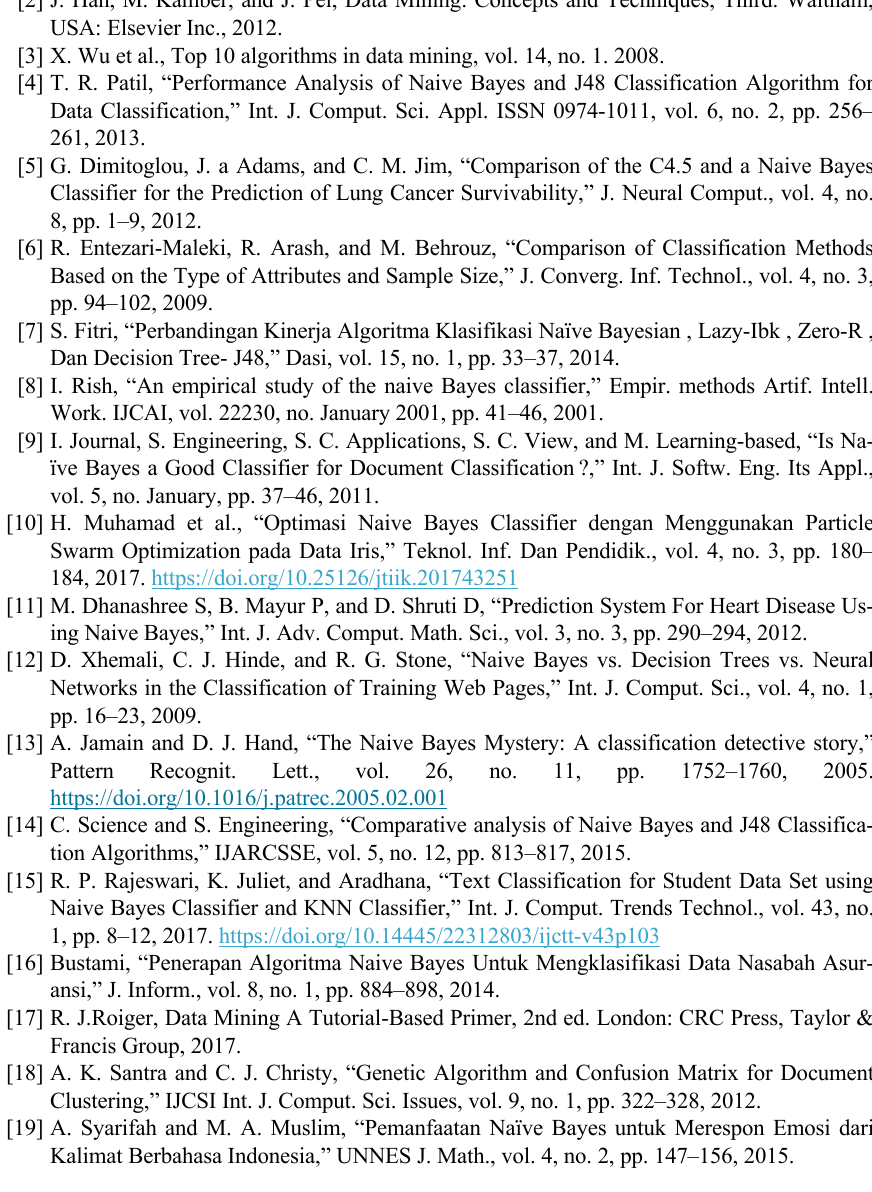
Short Paper —Naïve Bayes Classifier for Journal Quartile